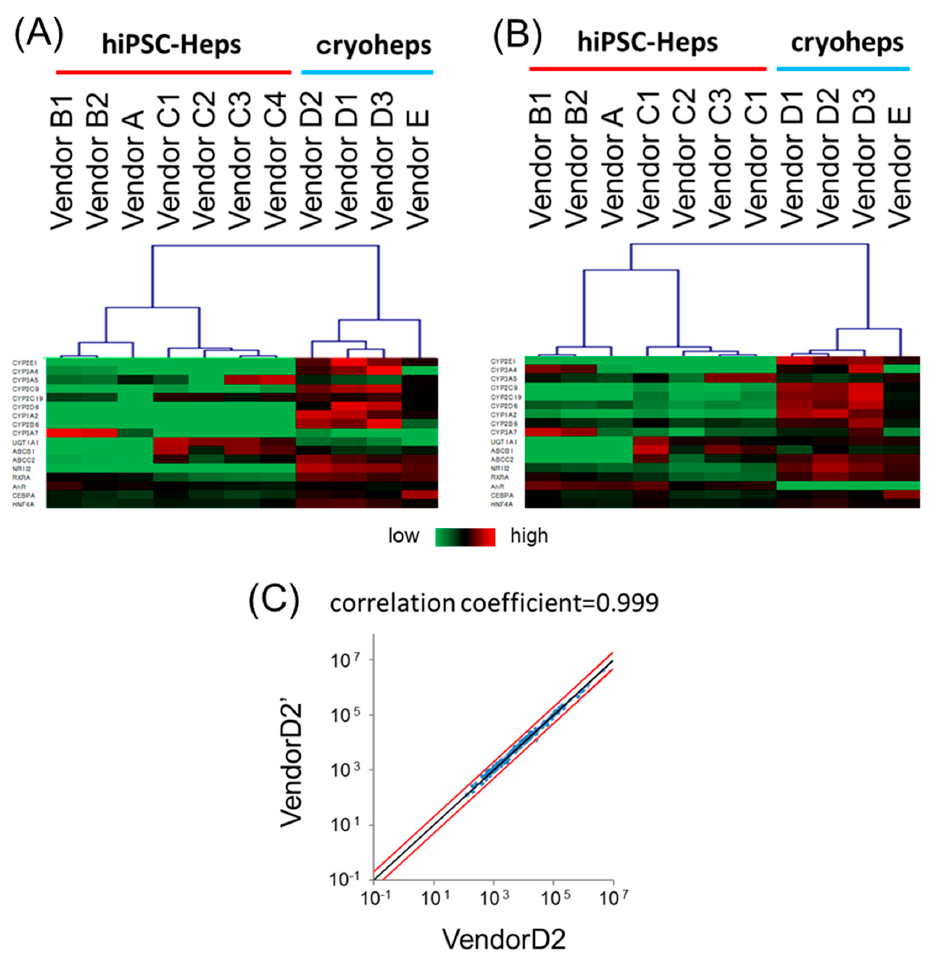
Figure 3. Reliability evaluation of the expression data from the Focused microarray assay. Expression data of 17 drug metabolism genes from the Focused microarray assay were compared with those from a qPCR. ( A ) Heatmap pattern and hierarchical clusters based on expression data from the Focused microarray assay. ( B ) Heatmap pattern and hierarchical clusters based on expression data from the qPCR. The reproducibility of the Focused microarray assay was evaluated. ( C ) Scatter plot of the gene expression data from the Focused microarray assay using cryopreserved human hepatocytes from the same donor. The black line exhibits an equal-fold change, and the red line exhibits a two-fold change.